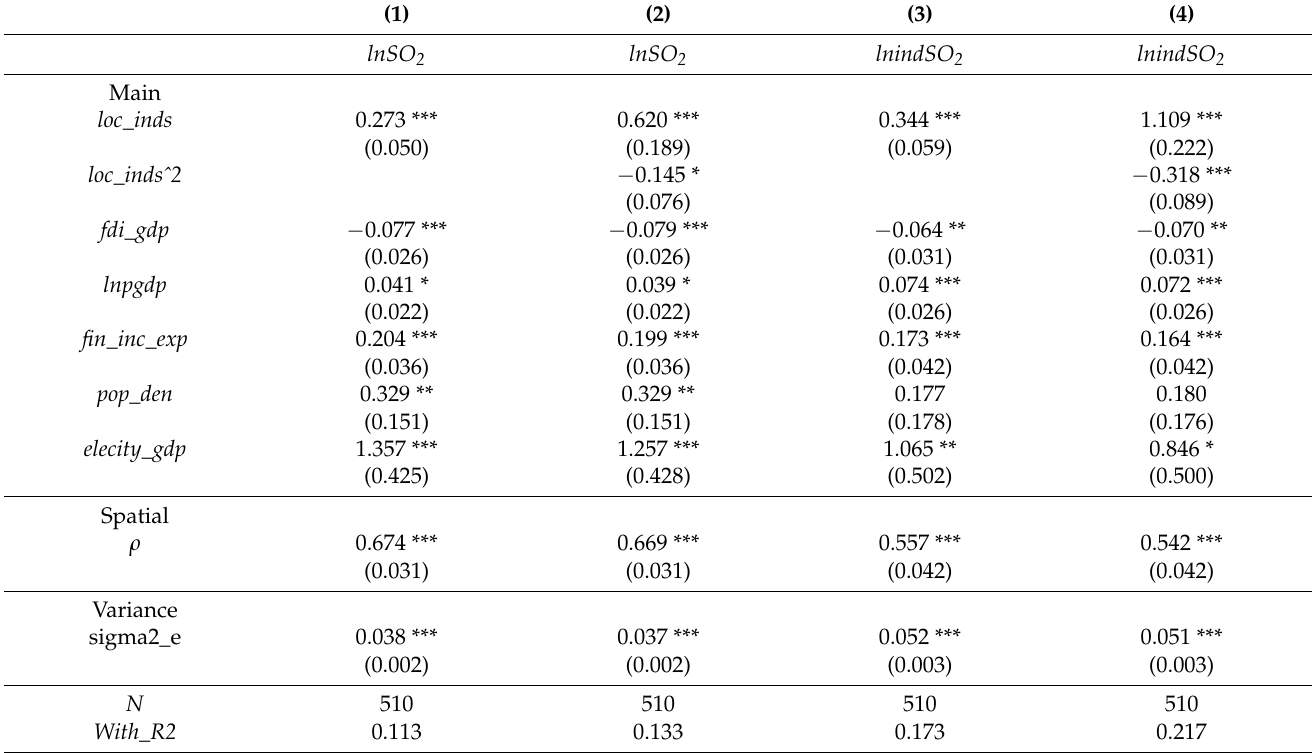
Table 3. Results of Spatial Autoregressive Model